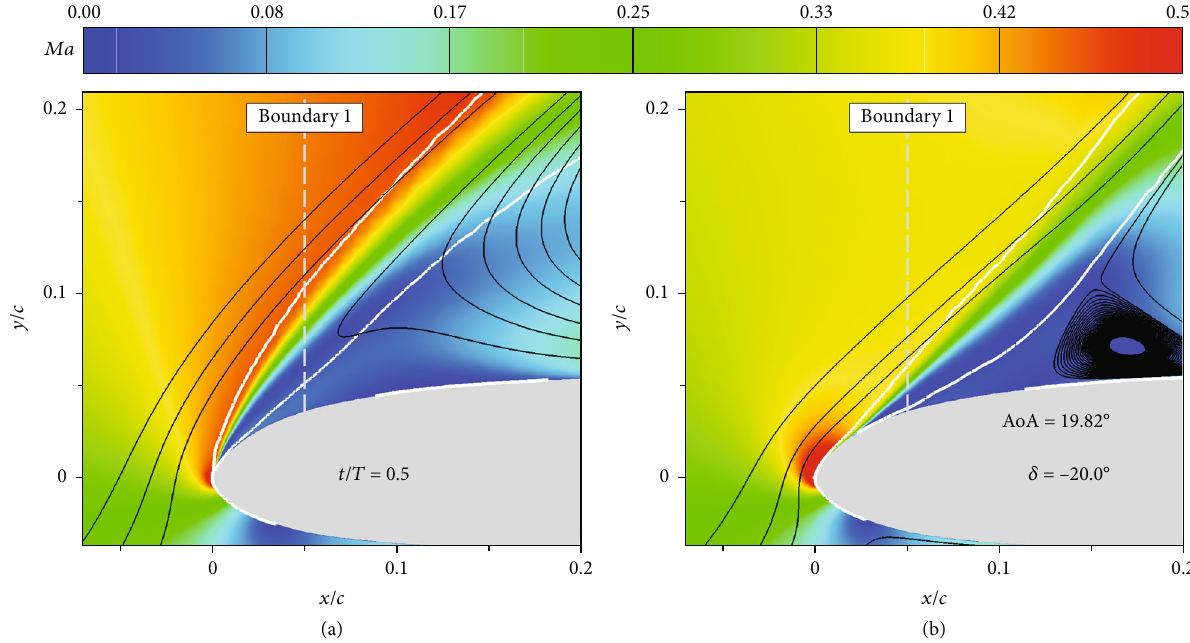
Figure 23: Streamlines and Mach number contours around the leading edge at t / T = 0 : 5 for the two airfoils: (a) original airfoil and (b) TEF airfoil. The solid white line represents the contour line that the normalized vorticity is